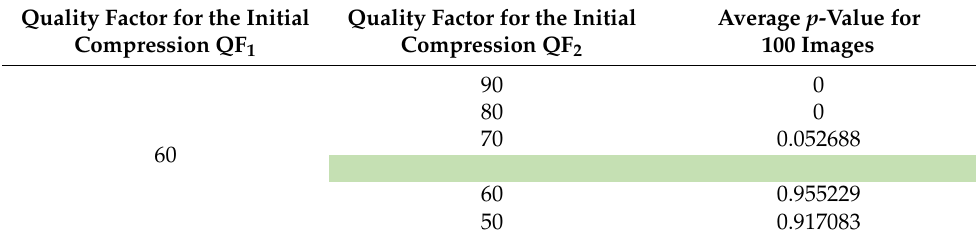
Table 5. Comparison between JPEG coefficients and the GBL, using Y channel. Quality Factor for the